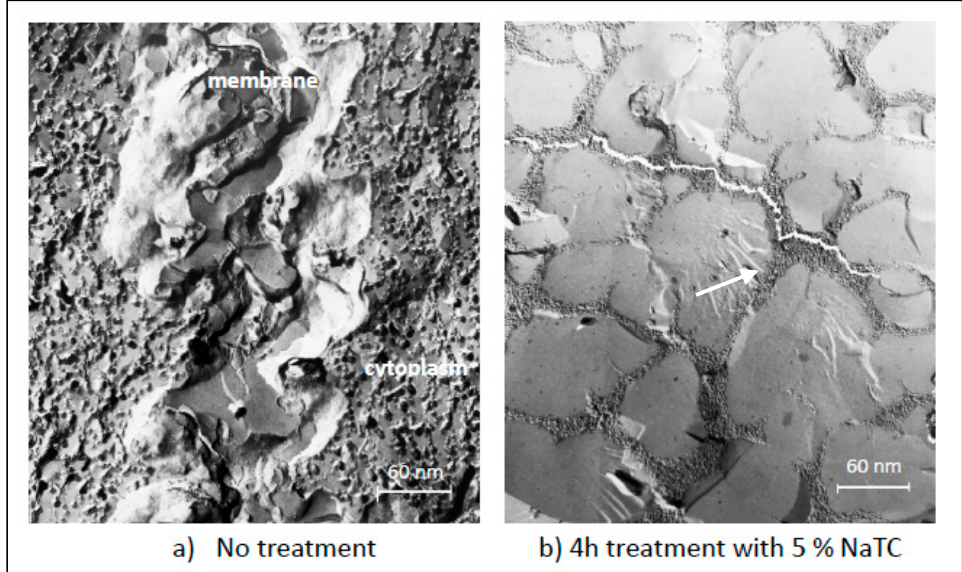
Figure 3. Freeze-fracture micrographs of porcine buccal mucosa: ( a ) intact and ( b ) treated for 4 h with sodium taurocholate (NaTC). The arrow depicts the lamellar and rough domains in cytoplasm and the absence of a membrane structure. The Methodology of Freeze-Fracture Microscopy for the micrographs given in Supplementary Materials.